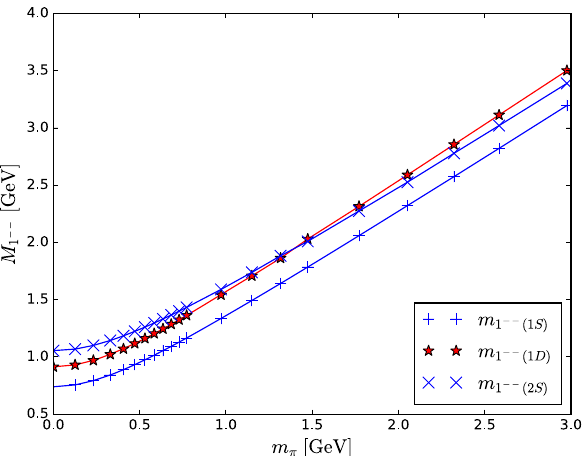
Fig. 9 S - and D -wave assignments of states in the 1 −− channel as functions of the pion mass